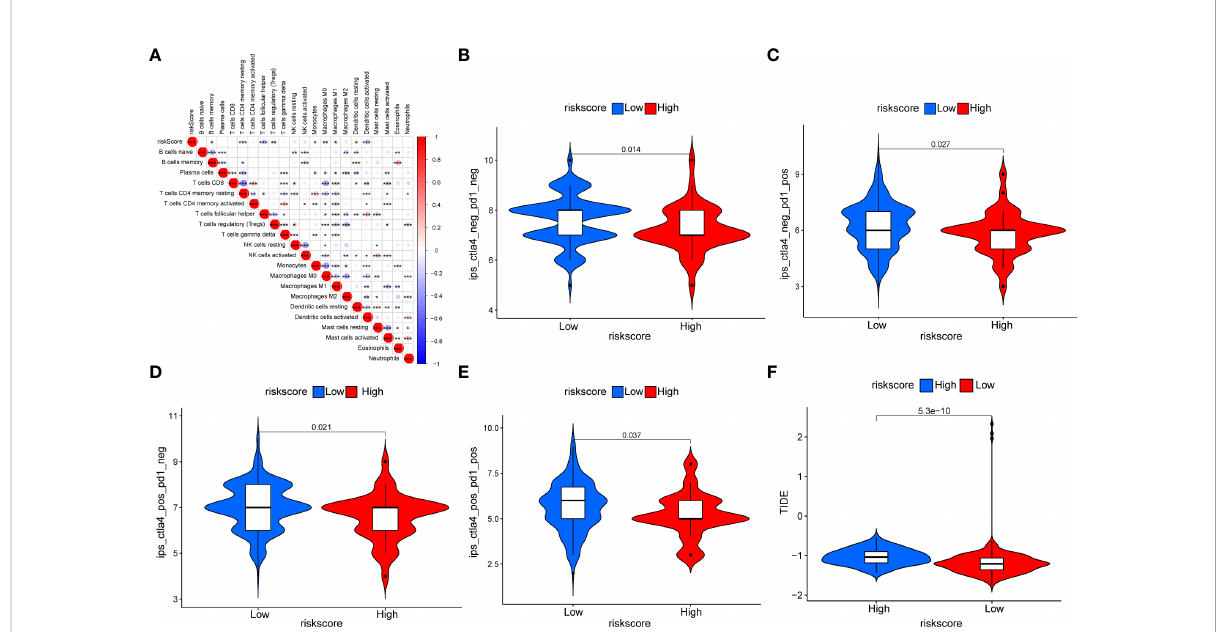
FIGURE 13 Relationship between the CAF riskscore and immunity. (A) The correction between the CAF riskscore and the 22 TME in fi ltration cells based on the CIBERSORT algorithm. (B – E) The relationship between IPS and CAF riskscore groups in EOC patients. The IPS-CTLA4-/PD-L1- (B) , IPS- CTLA4-/PD-L1+ (C) , IPS-CTLA4+/PD-L1- (D) , and IPS-CTLA4+/PD-L1+ (E) were higher in the low-riskscore group than in the high-riskscore group (all p < 0.05). (F) The TIDE prediction value was signi fi cantly higher in the high-riskscore group than that in the low-riskscore